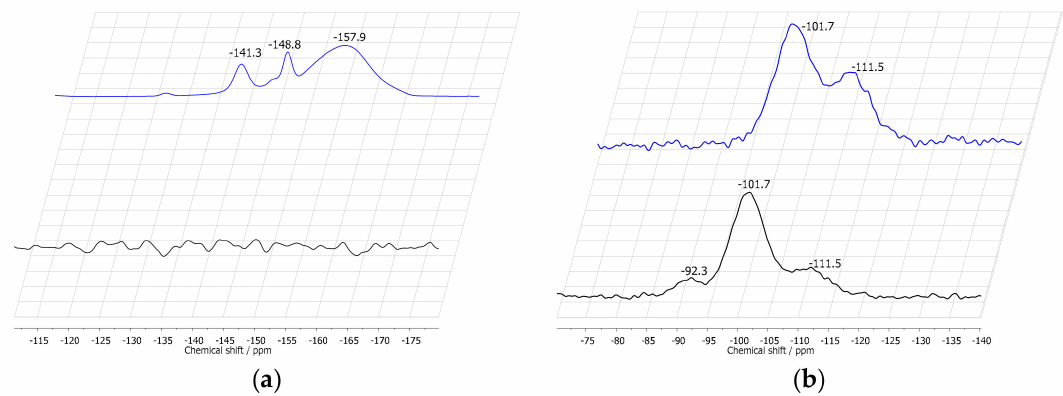
Figure 2. CP / MAS 19 F ( a ) and CP / MAS 29 Si ( b ) solid-state NMR spectra. Black line: SiO 2 (c). Blue line: SiO 2 (c)F. All spectra were collected at a spin rate of 10 kHz. The chemical shift value at the top of the peak is indicated by the curve.